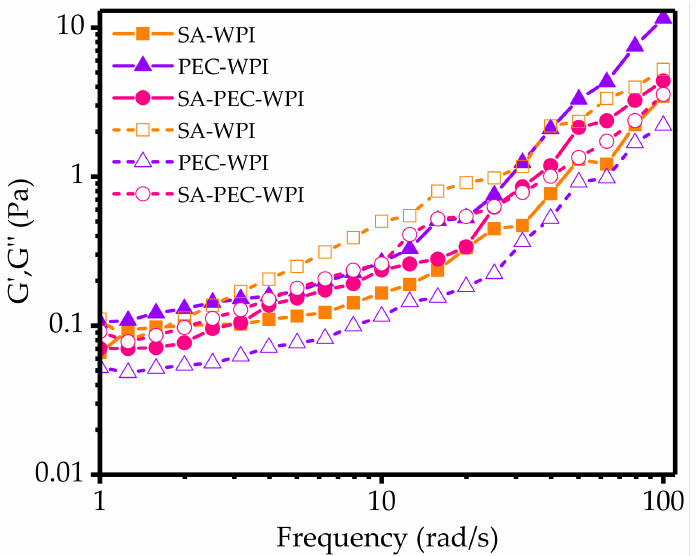
Figure 6. Dynamic frequency sweep of all emulsions. G (cid:48) in solid line is storage modulus, and G (cid:48)(cid:48) in dashed line is loss modulus. SA: sodium alginate; PEC: pectin; WPI: whey protein